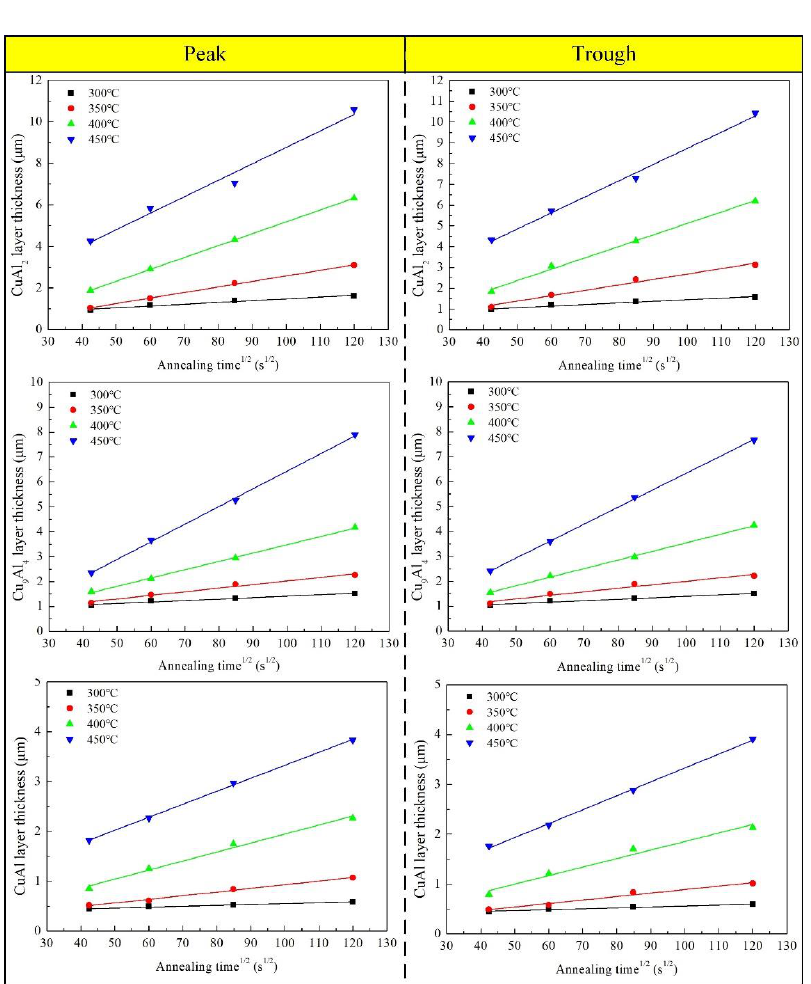
Figure 5. Function of intermetallic sub-layer thickness and annealing time. According to classical kinetic theory, the activation energies for IMCs growth can be